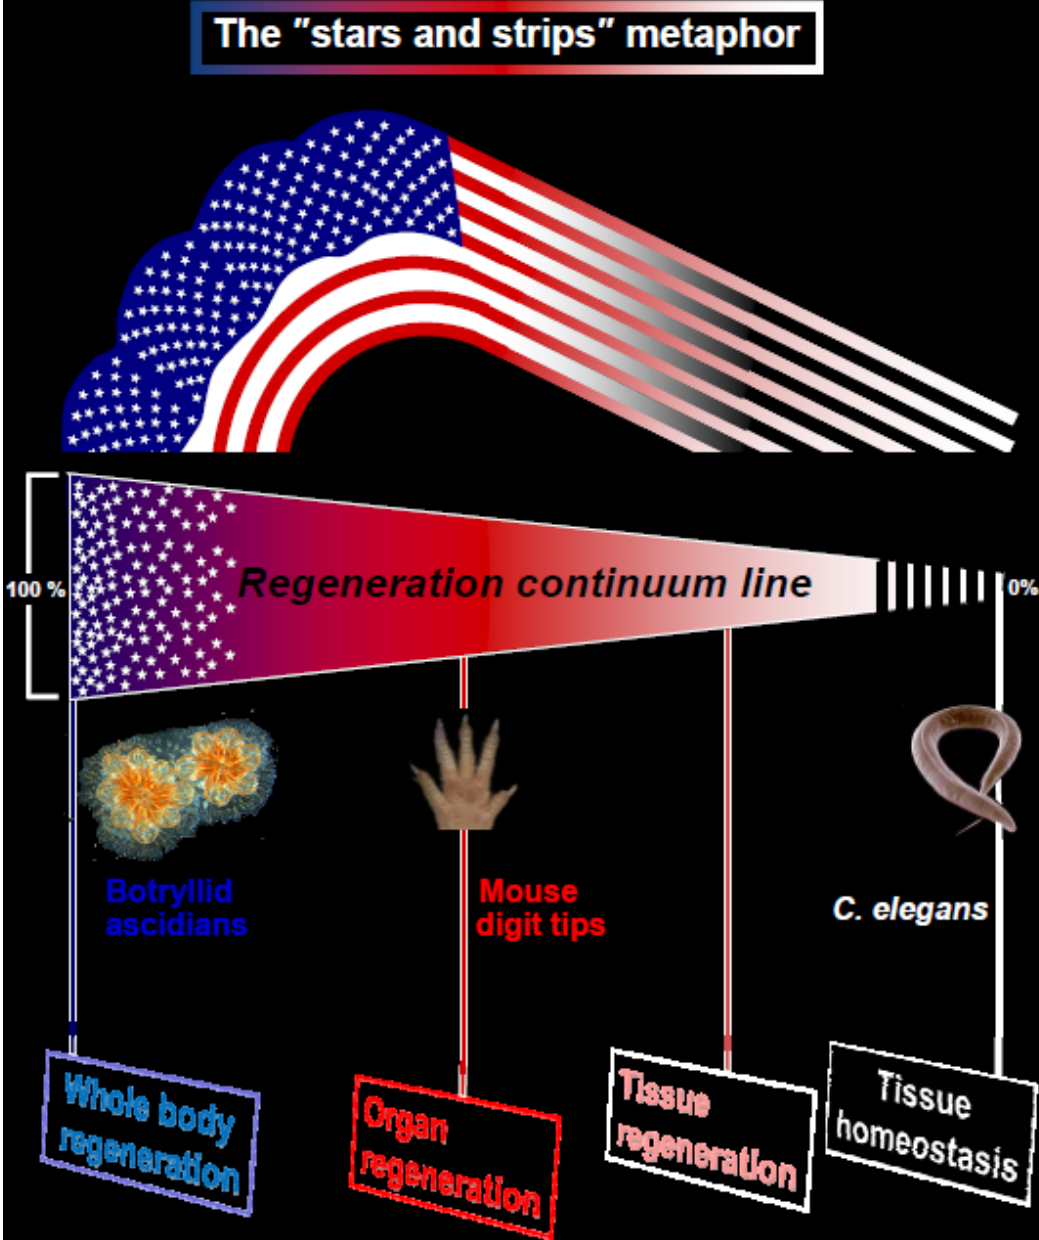
Figure 1. Regeneration in metazoans. (cid:55)(cid:75)(cid:72)(cid:3) (cid:76)(cid:79)(cid:79)(cid:88)(cid:86)(cid:87)(cid:85)(cid:68)(cid:87)(cid:72)(cid:71)(cid:3) (cid:80)(cid:72)(cid:87)(cid:68)(cid:83)(cid:75)(cid:82)(cid:85)(cid:3) (cid:82)(cid:73)(cid:3) (cid:87)(cid:75)(cid:72)(cid:3) (cid:56)(cid:54)(cid:36)(cid:3) (cid:179)(cid:86)(cid:87)(cid:68)(cid:85)(cid:86)(cid:3) (cid:68)(cid:81)(cid:71)(cid:3) (cid:86)(cid:87)(cid:85)(cid:76)(cid:83)(cid:72)(cid:86)(cid:180)(cid:3) (cid:73)(cid:79)(cid:68)(cid:74)(cid:15)(cid:3) (cid:90)(cid:76)(cid:87)(cid:75)(cid:3) four assigned distinct regeneration turning points outlined along the (cid:80)(cid:88)(cid:79)(cid:87)(cid:76)(cid:70)(cid:72)(cid:79)(cid:79)(cid:88)(cid:79)(cid:68)(cid:85)(cid:3) (cid:82)(cid:85)(cid:74)(cid:68)(cid:81)(cid:76)(cid:86)(cid:80)(cid:86)(cid:3) (cid:179)(cid:85)(cid:72)(cid:74)(cid:72)(cid:81)(cid:72)(cid:85)(cid:68)(cid:87)(cid:76)(cid:82)(cid:81)(cid:3) (cid:70)(cid:82)(cid:81)(cid:87)(cid:76)(cid:81)(cid:88)(cid:88)(cid:80)(cid:180)(cid:17)(cid:3) (cid:55)(cid:20)(cid:3) (cid:68)(cid:81)(cid:71)(cid:3) (cid:55)(cid:21)(cid:3) (cid:82)(cid:85)(cid:74)(cid:68)(cid:81)(cid:76)(cid:86)(cid:80)(cid:86)(cid:3) (cid:86)(cid:83)(cid:72)(cid:70)(cid:76)(cid:73)(cid:92)(cid:3) (cid:87)(cid:75)(cid:72)(cid:3) (cid:179)(cid:58)(cid:75)(cid:82)(cid:79)(cid:72)(cid:3) (cid:69)(cid:82)(cid:71)(cid:92)(cid:3) (cid:85)(cid:72)(cid:74)(cid:72)(cid:81)(cid:72)(cid:85)(cid:68)(cid:87)(cid:76)(cid:82)(cid:81)(cid:180)(cid:3) (cid:68)(cid:81)(cid:71)(cid:3) (cid:179)(cid:50)(cid:85)(cid:74)(cid:68)(cid:81) (cid:85)(cid:72)(cid:74)(cid:72)(cid:81)(cid:72)(cid:85)(cid:68)(cid:87)(cid:76)(cid:82)(cid:81)(cid:180)(cid:3) (cid:86)(cid:87)(cid:85)(cid:68)(cid:87)(cid:72)(cid:74)(cid:76)(cid:72)(cid:86)(cid:3) (cid:90)(cid:76)(cid:87)(cid:75)(cid:3) (cid:80)(cid:82)(cid:71)(cid:72)(cid:79)(cid:3) (cid:70)(cid:68)(cid:86)(cid:72)(cid:86)(cid:15)(cid:3) (cid:87)(cid:75)(cid:72)(cid:3) botryllid ascidians regeneration and the murine digit tip regeneration,